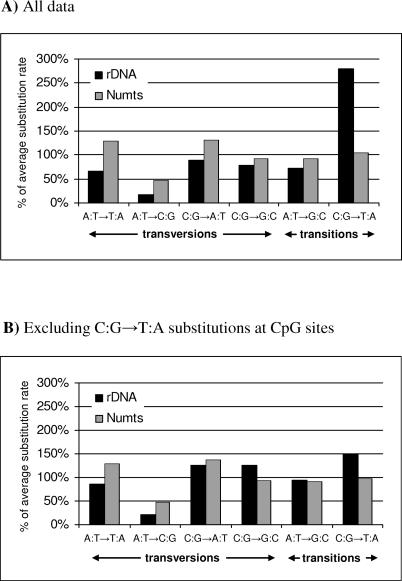
Neutral Point Substitution Patterns in Two Types of Grasshopper Pseudogenes(A and B) Frequency of the different substitutions in rDNA pseudogenes (black) and Numts (grey) expressed as a percentage of the average substitution rate.